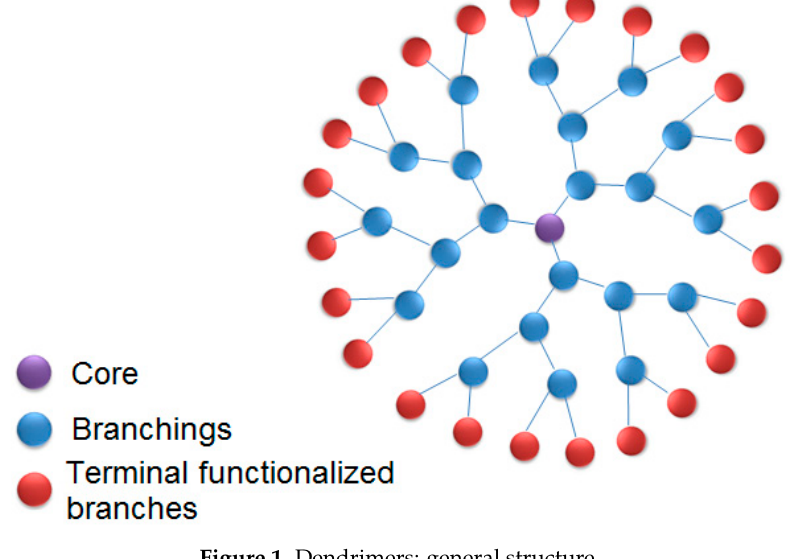
Figure 1. Dendrimers: general structure.